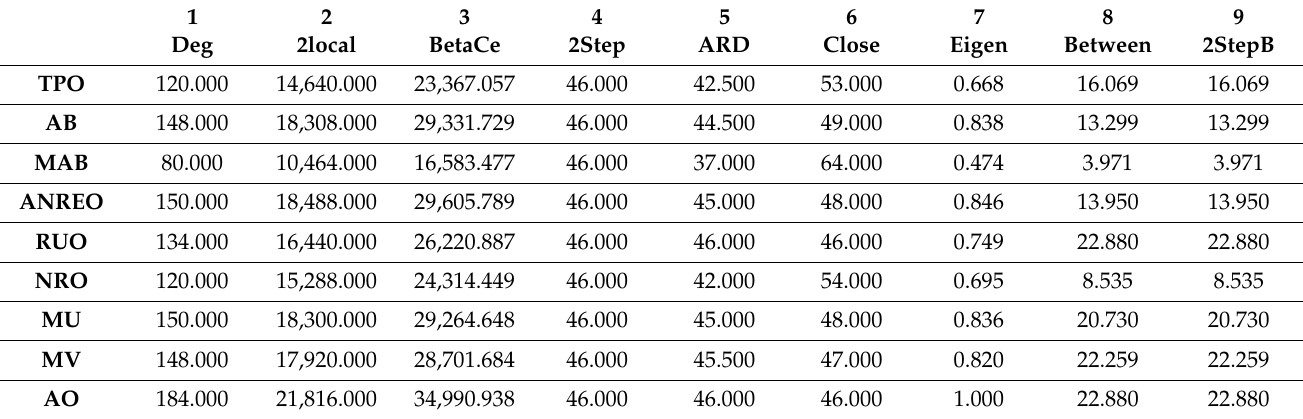
Table A5. Multiple centrality measures of actants involved in the transition, calculated by